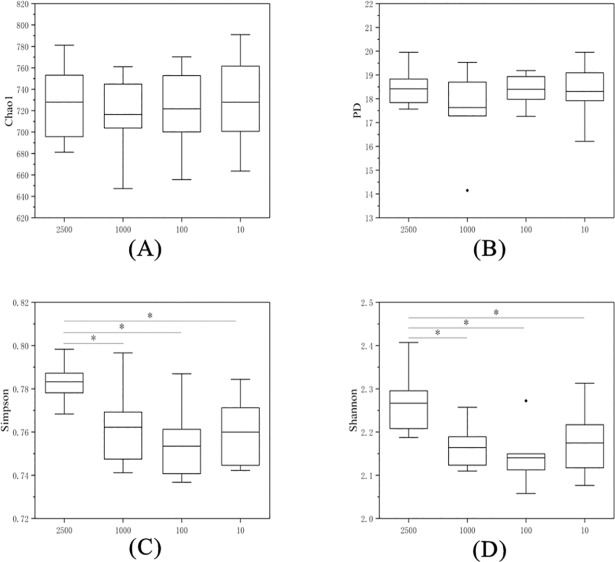
Archaea alpha diversity indices.(A) Chao1, (B) phylogenetic distance, (C) Simpson, and (D) Shannon index values of the cecal contents of rabbits. The samples were labelled 2500, 1000, 100, 10 according to different particle size of ground alfalfa hay. There are six replicates in each group.